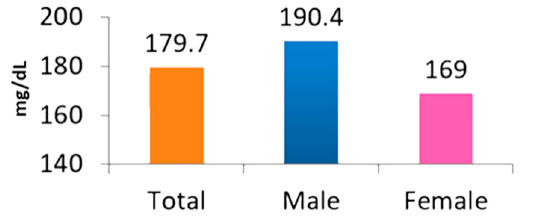
Figure 2. Total blood cholesterol level of the studied population in Bogor area, Indonesia.